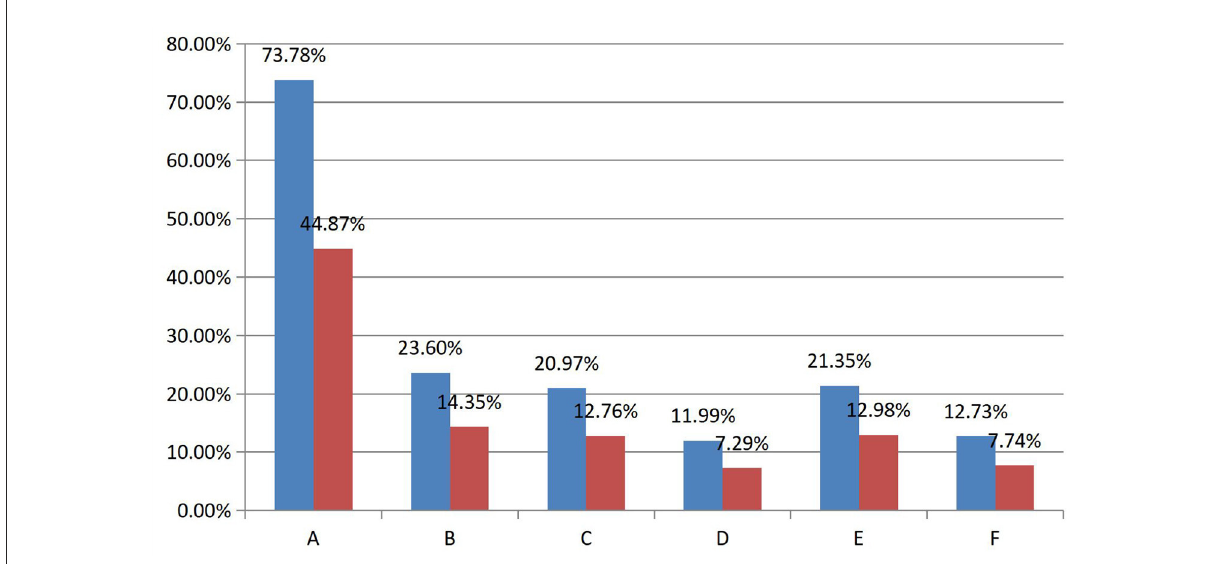
FIGURE4 Summary table of response rates and prevalence rates. (A) I spend a lot of time reading other viewers’ live comments. (B) I write live comments to connect with other viewers. (C) I write live comments to connect with the streamer. (D) I watch the streamer longer when my comments are replied to (E). I feel that I am actually there in person. (F) I get attention when I see streamers thanking or mentioning virtual gifts or donations from other viewers. (blue bar is prevalence rates, red bar is response rates. See Table 4 in the Appendix for specific